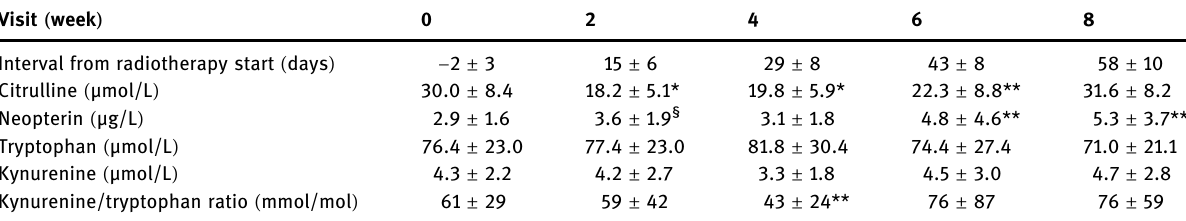
Table 1: Changes of citrulline, neopterin, kynurenine, and tryptophan concentrations during the course of the treatment Visit ( week ) 0